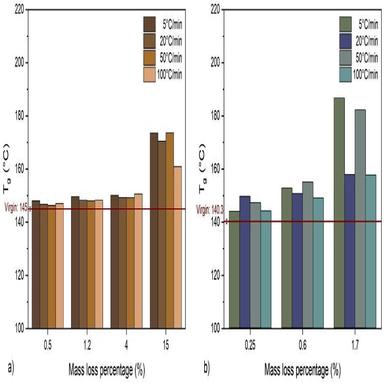
Tg of a) PEEK and b) CF-PEEK as degradation progresses for the heating rates of 5, 20, 50 and 100 ◦C/min.